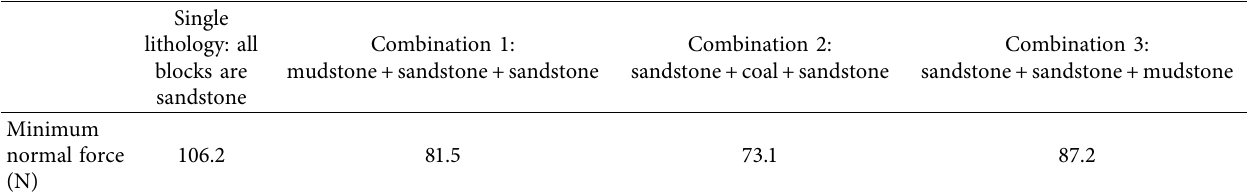
Table 8: Minimum normal force on the contact surface under different